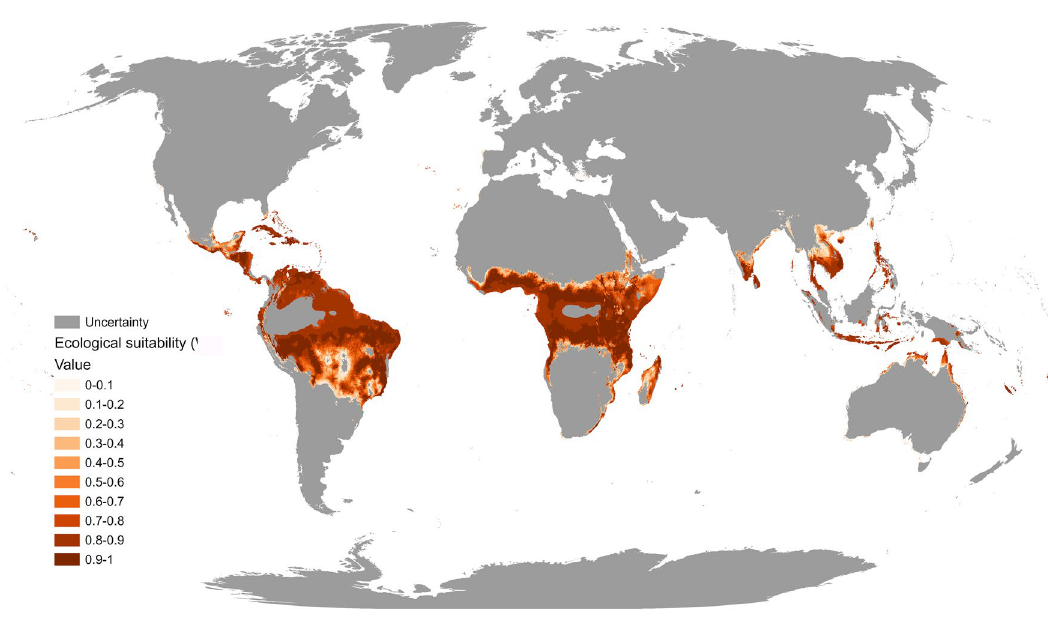
Figure 4. S. exempta present-time worldwide environmental suitability model. Grey areas represent uncertainty, calculated through MESS approach 47 . The map was generated in R v.4.0.2 104 (https:// www.r- proje ct. org/) using RStudio v.1.3.1093 (https:// www. rstud io.